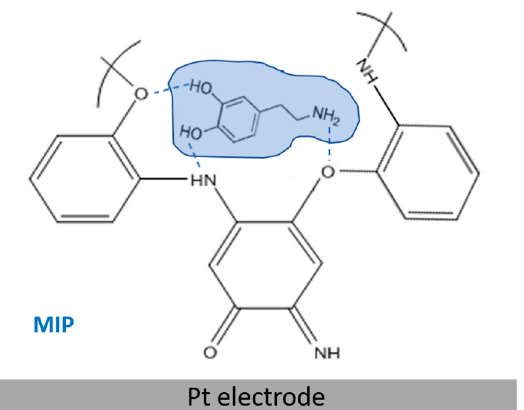
Scheme 1. Schematic representation of the possible interactions between the template molecules and the imprinted cavities within the MIP. PoAP functionalities are reported according to the